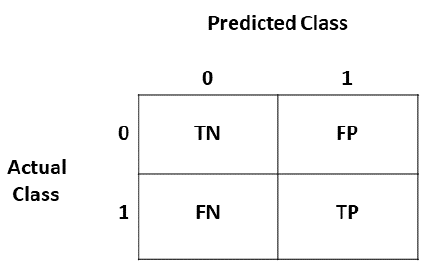
Figure 7. Confusion